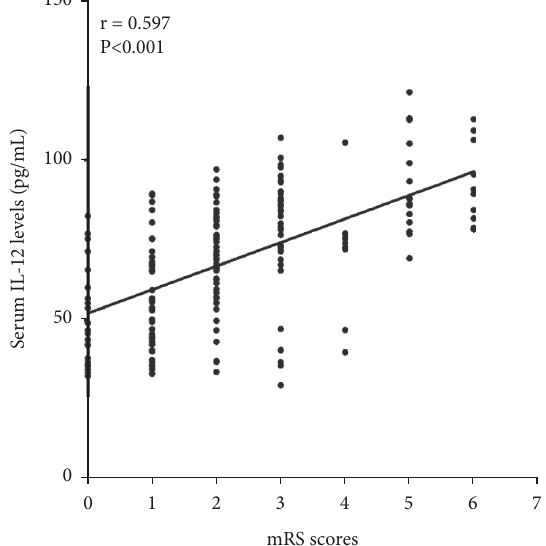
Figure 6: Scatter plot showing the correlation of serum IL-12 levels with mRS scores followed by intracerebral hemorrhage using spearman correlation coefficient.